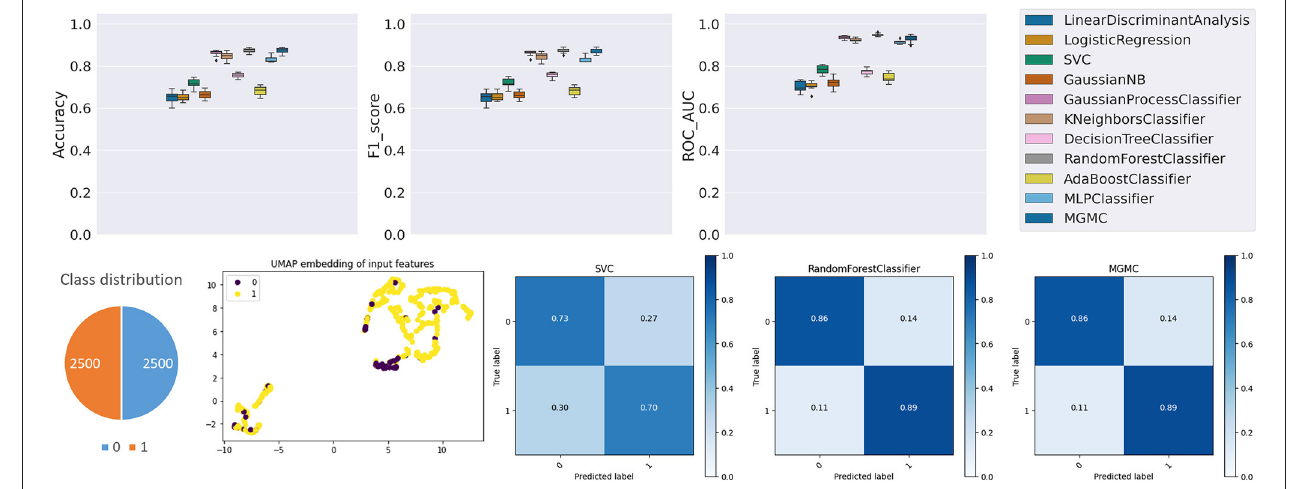
FIGURE A2 | Results panel produced by base-ml for Synthetic